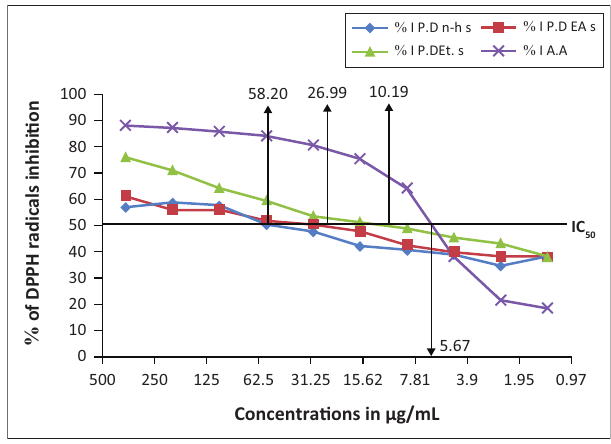
FIGURE 3: Percentage inhibition of DPPH (2,2-diphenyl-1-picrylhydrazyl) radical versus concentrations of stem extracts.